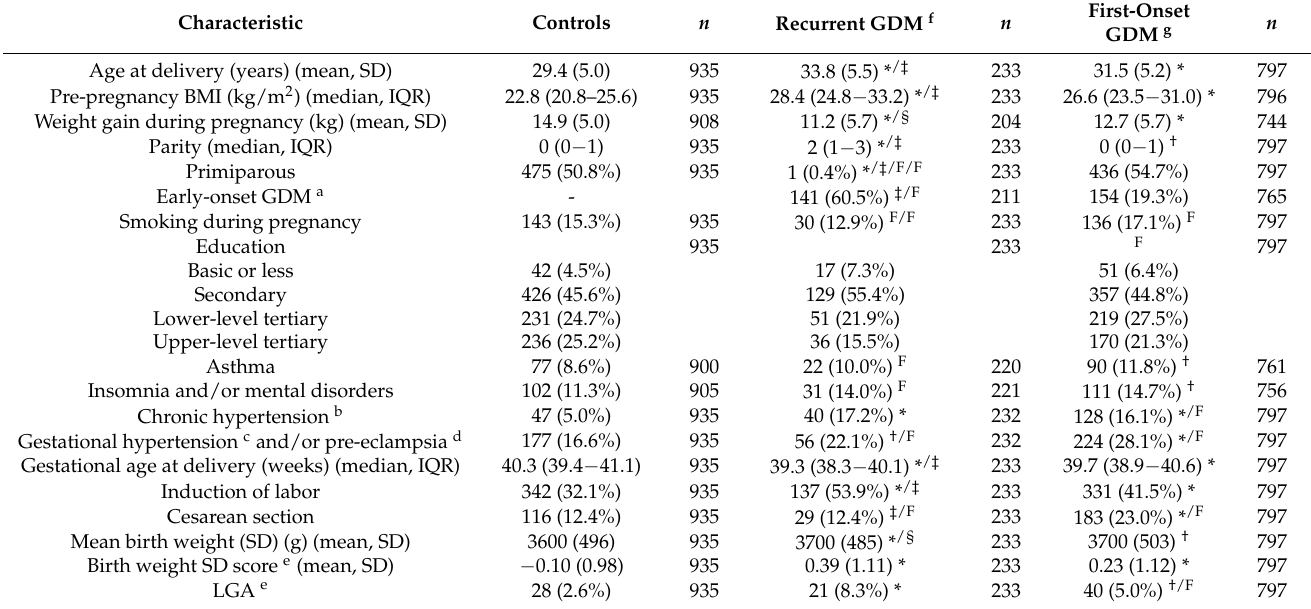
Table 3. Characteristics of the controls and women with recurrent or first-onset gestational diabetes.